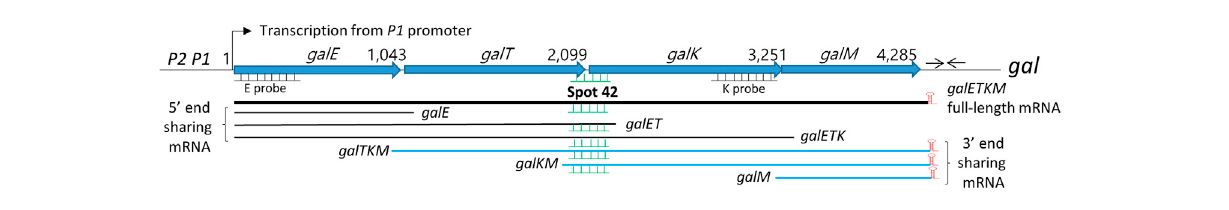
FIGURE 1 Mapof gal operonandthe3 ′ and5 ′ end-sharingmRNA. P1 and P2 arethetwopromotersofthe gal operonof Escherichiacoli whichareseparatedby fi ve nucleotides. Numbers indicate gal nucleotide residue coordinates, where one is the start of transcription from the P1 promoter. The number at the end of each gene belongs to the last nucleotide of the stop codon of that gene. Six nucleotides downstream of the stop codon of the galM gene is a 17- nucleotide inverted repeat sequence (head-to-head arrows) that forms the terminator hairpin (red) that terminates transcription and protects the full-length galETKM mRNA from 3 ′ → 5 ′ exonuclease digestion. Two DNA probes, E and K (500 bp) (underlines) used in the Northern blots are presented. The galETKM operonproducestwokindsofmRNAgroups:3 ′ end-sharing and5 ′ end-sharing.The3 ′ end-sharingmRNAsharesthesame3 ′ endwiththe full-length galETKM mRNA.The5 ’ end-sharingmRNAsharesthesame5 ′ endwiththe galETKM mRNA.TheEandKprobeswereusedtodetectthe5 ′ end- sharing and 3 ′ end-sharing mRNA, respectively. Spot 42 (green) binds at the translation initiation region of the galK gene. Thus, Spot 42 binds to multiple